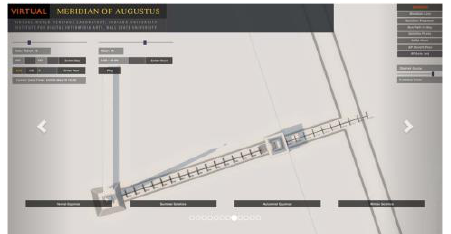
Figure 18: Shadow of the obelisk towards Ara Pacis, 19.3.9 AD, 15h